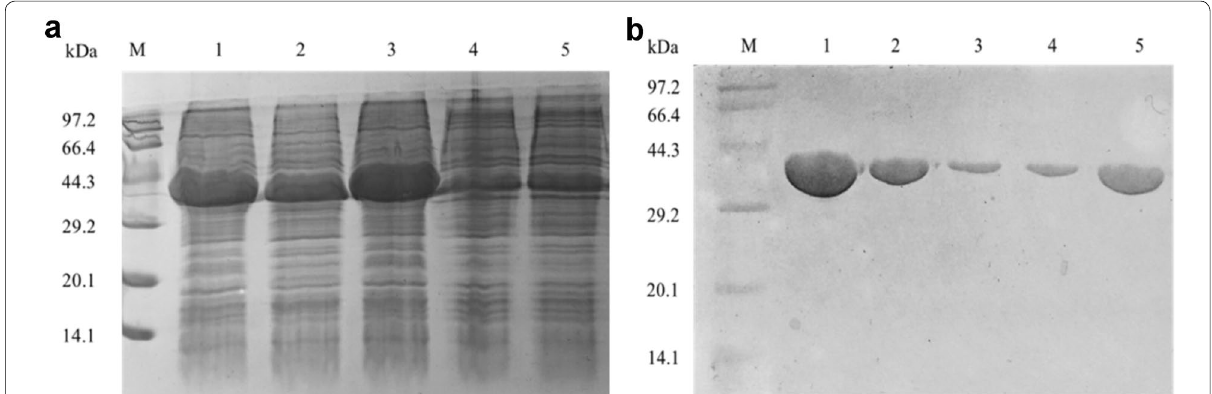
Fig. 2 SDS-PAGE analysis of a expression and b purification of the enzymes. Line M, molecular weight standard; lane 1, CaCR; lane 2, ScCR; lane 3, KmCR; lane 4, CPR-C1; lane 5, CPR-C2